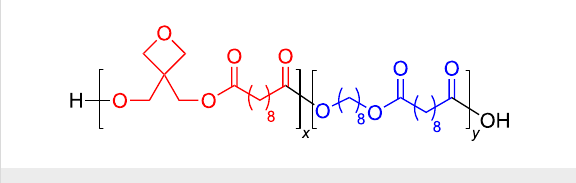
Figure 16: Polyesters containing reactive ether moieties.